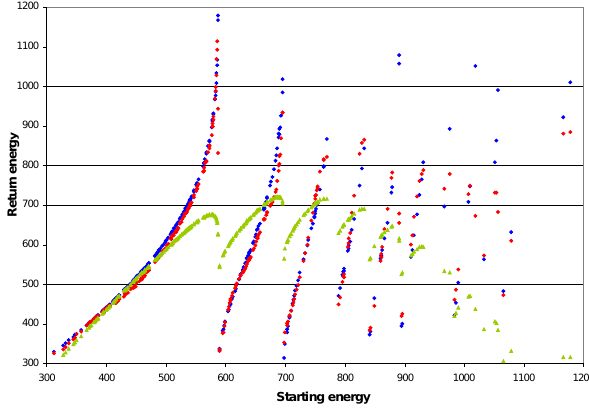
Fig. 6. Dynamical relation between starting energy maxima and return energy maxima (blue squares), NN forecasts (red diamonds) and multi-linear forecasts (green triangles) on a sample of the test set.